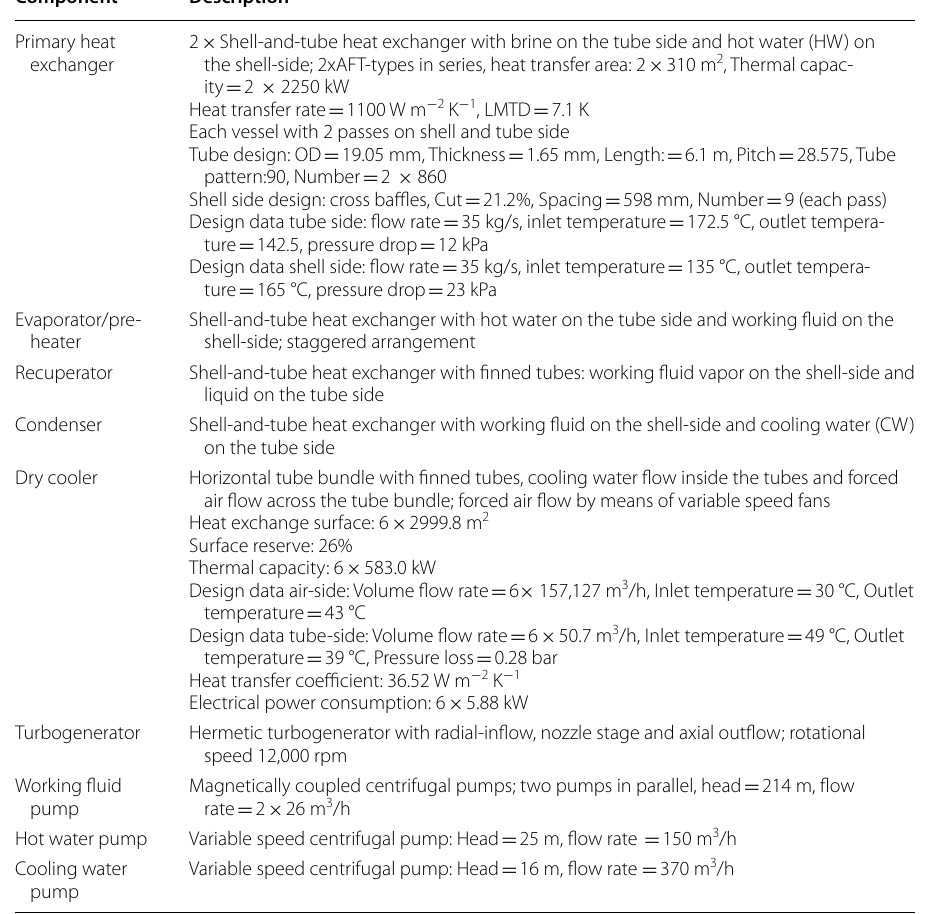
Table 1 Component specification of the demonstration plant Component Description